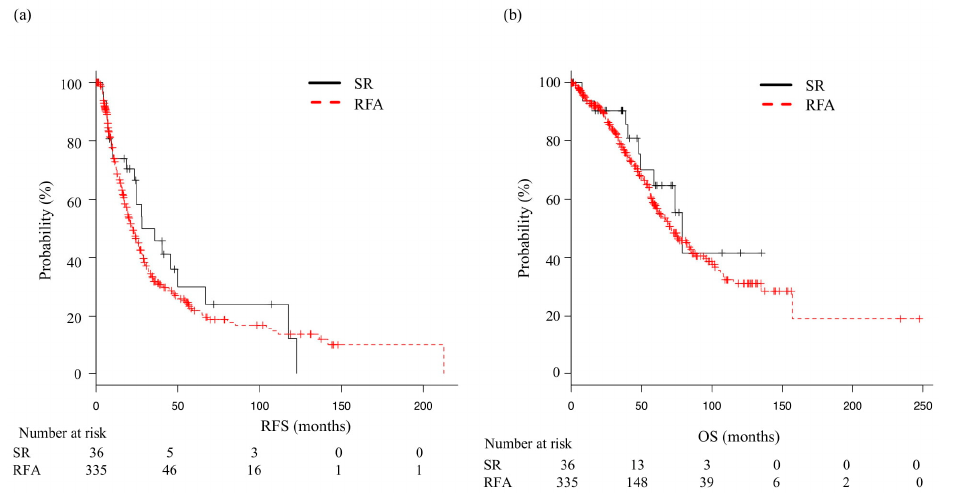
Figure 1. Recurrence-free and overall survival in patients who underwent surgical resection (SR) or radiofrequency ablation (RFA). ( a ) Median recurrence-free survival (mRFS) in the SR and RFA groups was 28.1 (95% CI: 23.4–50.0) and 22.1 (95% CI: 19.3–26.2) months, respectively ( p = 0.34). ( b ) Median overall survival (mOS) in the SR and RFA groups was 78.9 (95% CI: 49.3—not applicable) and 71.2 (95% CI: 61.8–84.7) months, respectively ( p = 0.337).